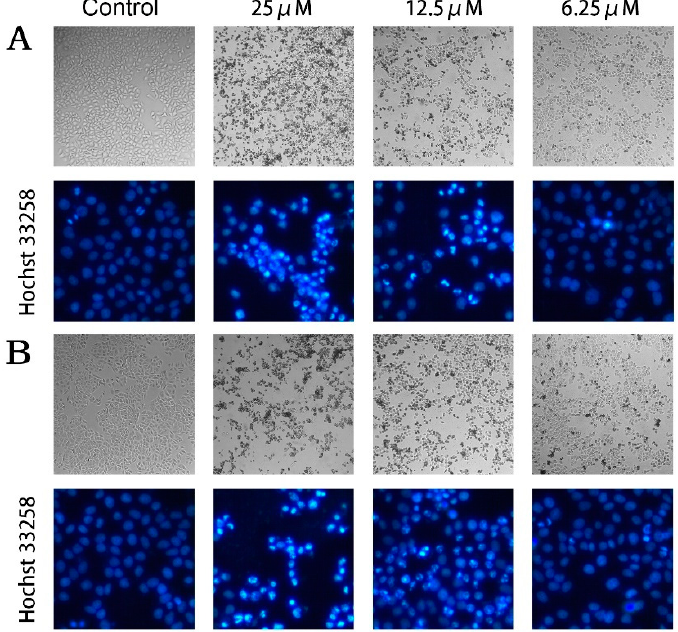
Figure 4. Compounds 2 and 5 induced apoptosis of MCF-7 cells. Morphological changes of cells exposed to various doses of compounds 2 ( A ) and 5 ( B ) for 24 h analyzed by microscopy observation (upper panels) in 100× and Hoechst 33258 fluorescent staining (below panels) in 400×.